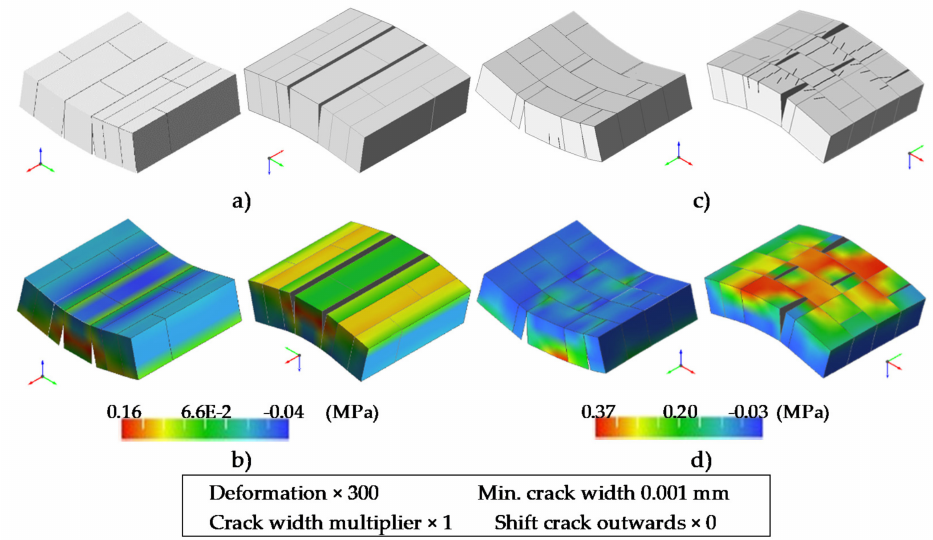
Figure 23. Crack and stress patterns on the calibrated computational models. ( a ) Deformed model; ( b ) Max. principal stress; ( c ) deformed model; ( d ) Max. principal